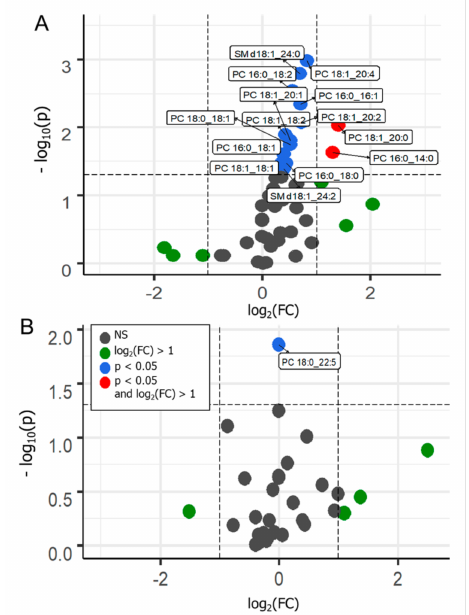
Figure 5. Volcano plots prepared from the data acquired from the ESI-QqQ/MS ( A ) and MALDI- ToF/MS ( B ) analysis, displaying the comparison between PCa vs. control cases. NS-nonsignificant; FC-fold change; significance threshold, p <